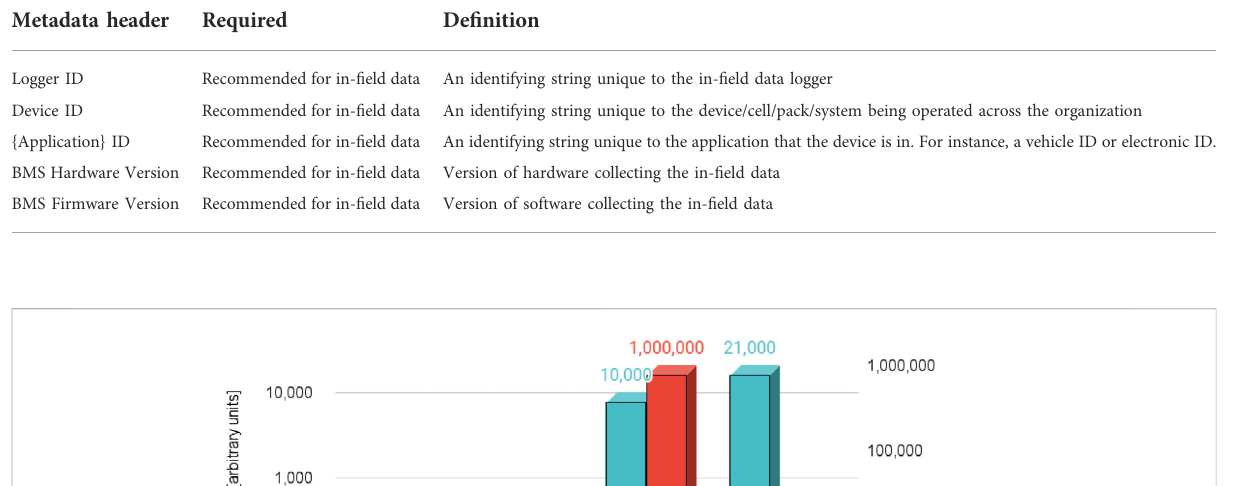
TABLE 5 Exemplary Metadata header entries for in- fi eld data collection.